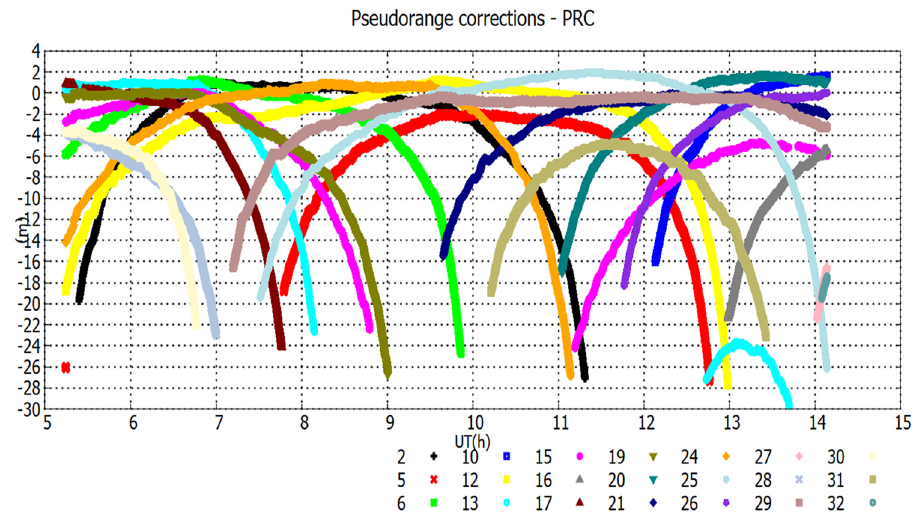
Figure 6: Pseudorange corrections from reference